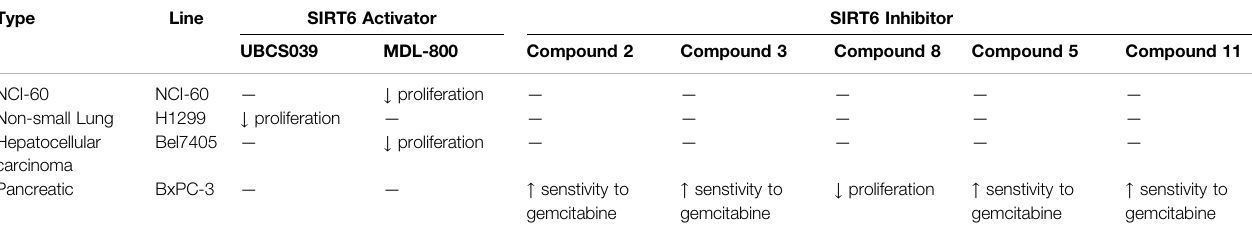
TABLE 6 | Cell lines affected by SIRT6